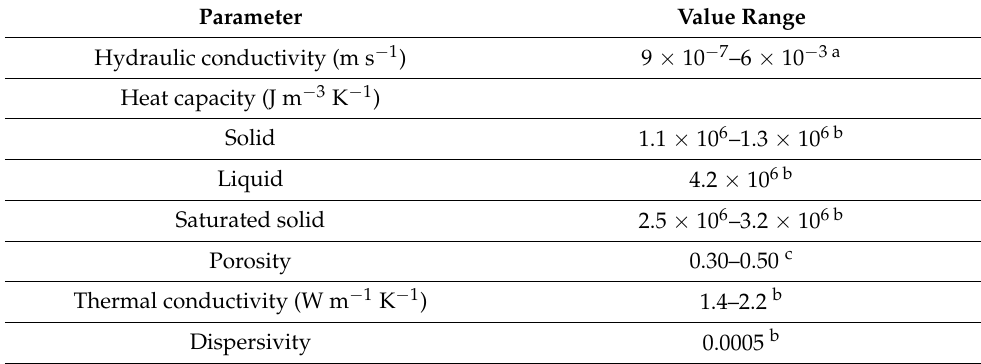
Table 2. Initial model parameter